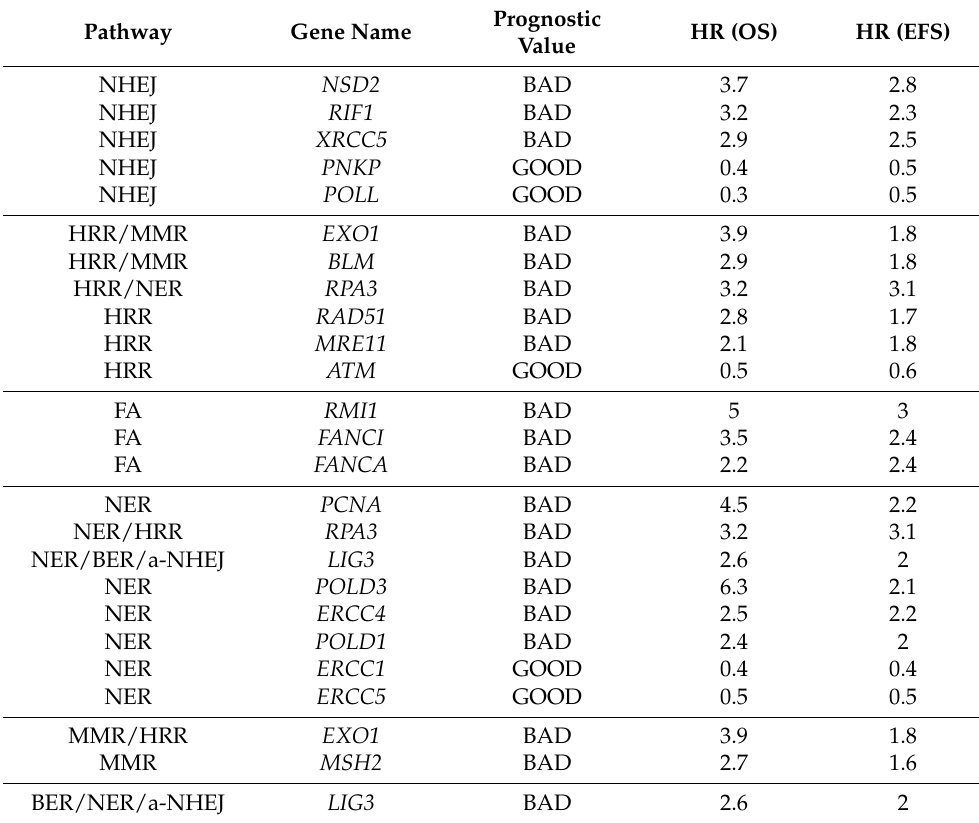
Table 1. DNA repair genes whose expression is assiciated with prognostic value. Of 84 genes, 22 had prognostic value for both overall surivival (OS) and event free survival (EFS). NHEJ, non-homologous end joining; HRR, homologous recombination repair MMR, mismatch repair, FA, Fanconi